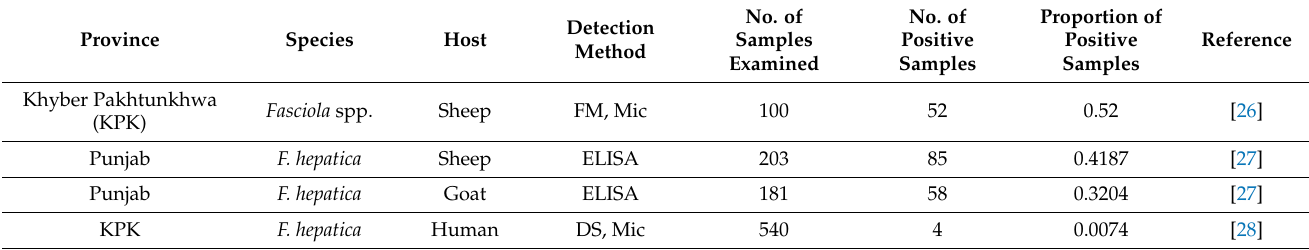
Figure 1. PRISMA flowchart describing the study design process. Table 1. Summary of the main characteristics of the studies included in the systematic review and